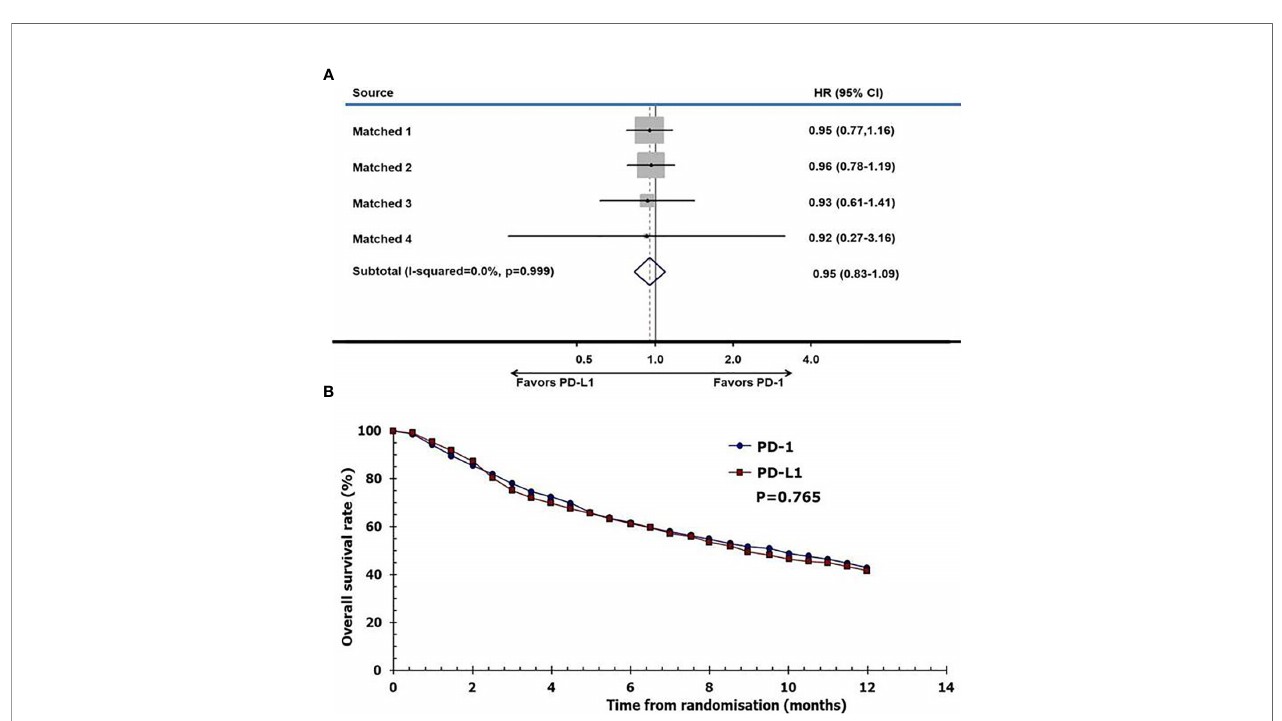
FIGURE 5 | Pooled hazard ratio of survival. (A) meta-analysis of pooled hazard ratios of overall survival outcomes of anti – PD-1 versus anti – PD-L1 therapy, (B) overall survival of patients with immune checkpoint inhibitors using reconstructed survival